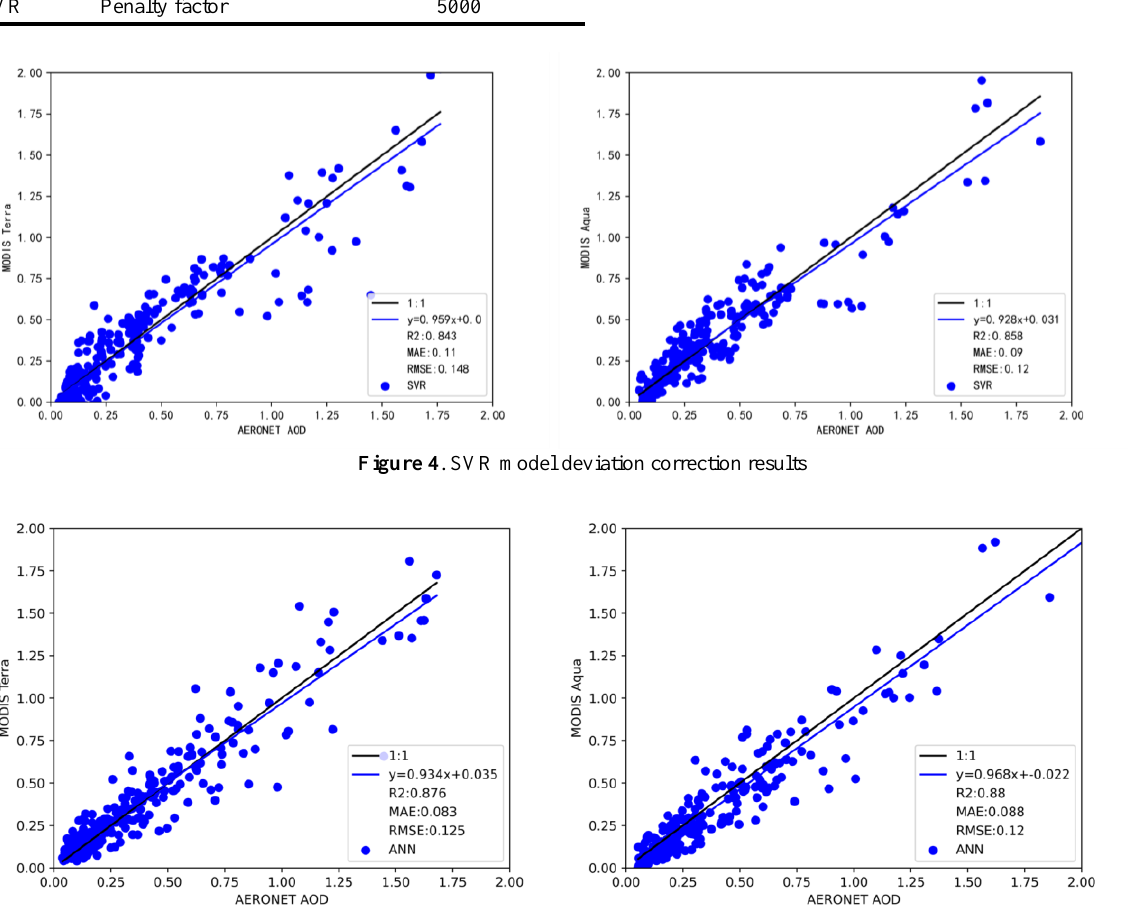
Figure 5 . ANN model deviation correction